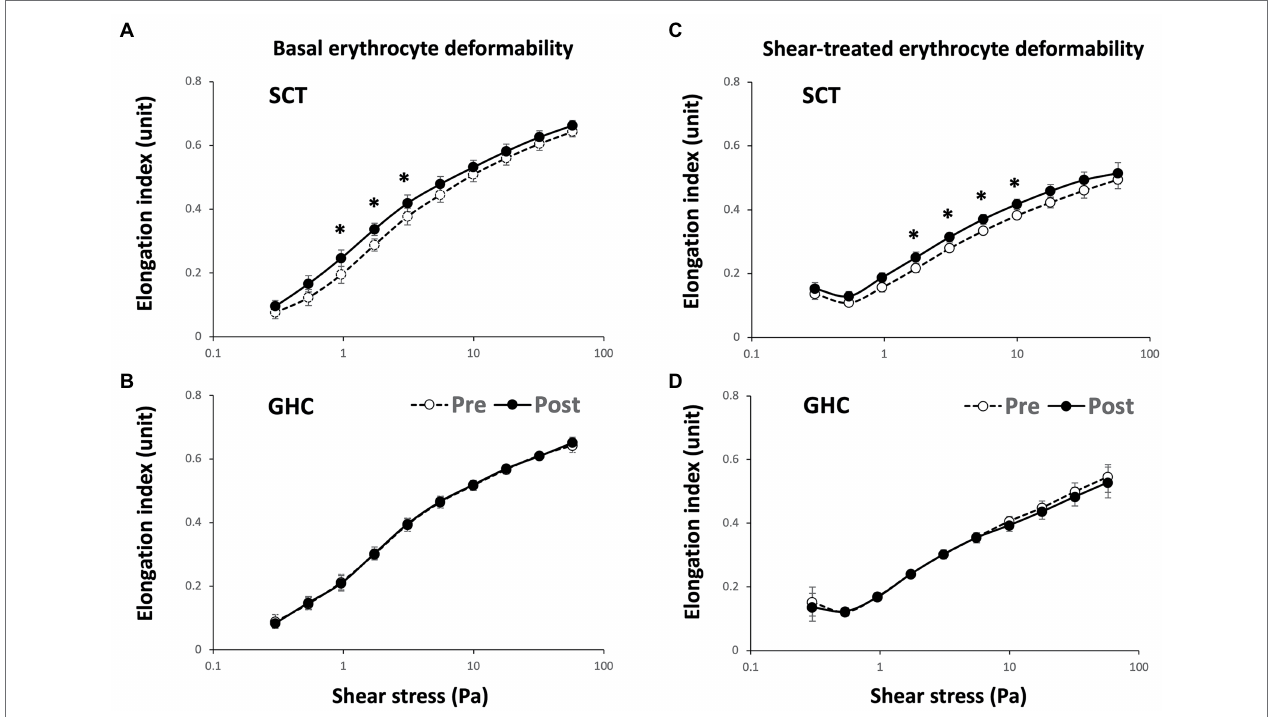
FIGURE 2 | Effect of SCT and GHC on erythrocyte membrane stability in participants with PAD. The erythrocyte membrane stability test included the initial deformability curve test at basal status [ (A) and (B) basal erythrocyte deformability] and the secondary deformability curve test followed the 50-Pa shear stress for 30 min [ (C) and (D) shear-treated erythrocyte deformability]. These deformability curves present the shear stress-elongation index (EI) curves for 10 consecutive shear stresses: 0.3, 0.54, 0.96, 1.73, 3.1, 5.56, 9.97, 17.88, 32.07, and 57.50 Pa. Pre, pre-intervention; Post, post-intervention. Values are mean ± SD. * p < 0.05, pre or